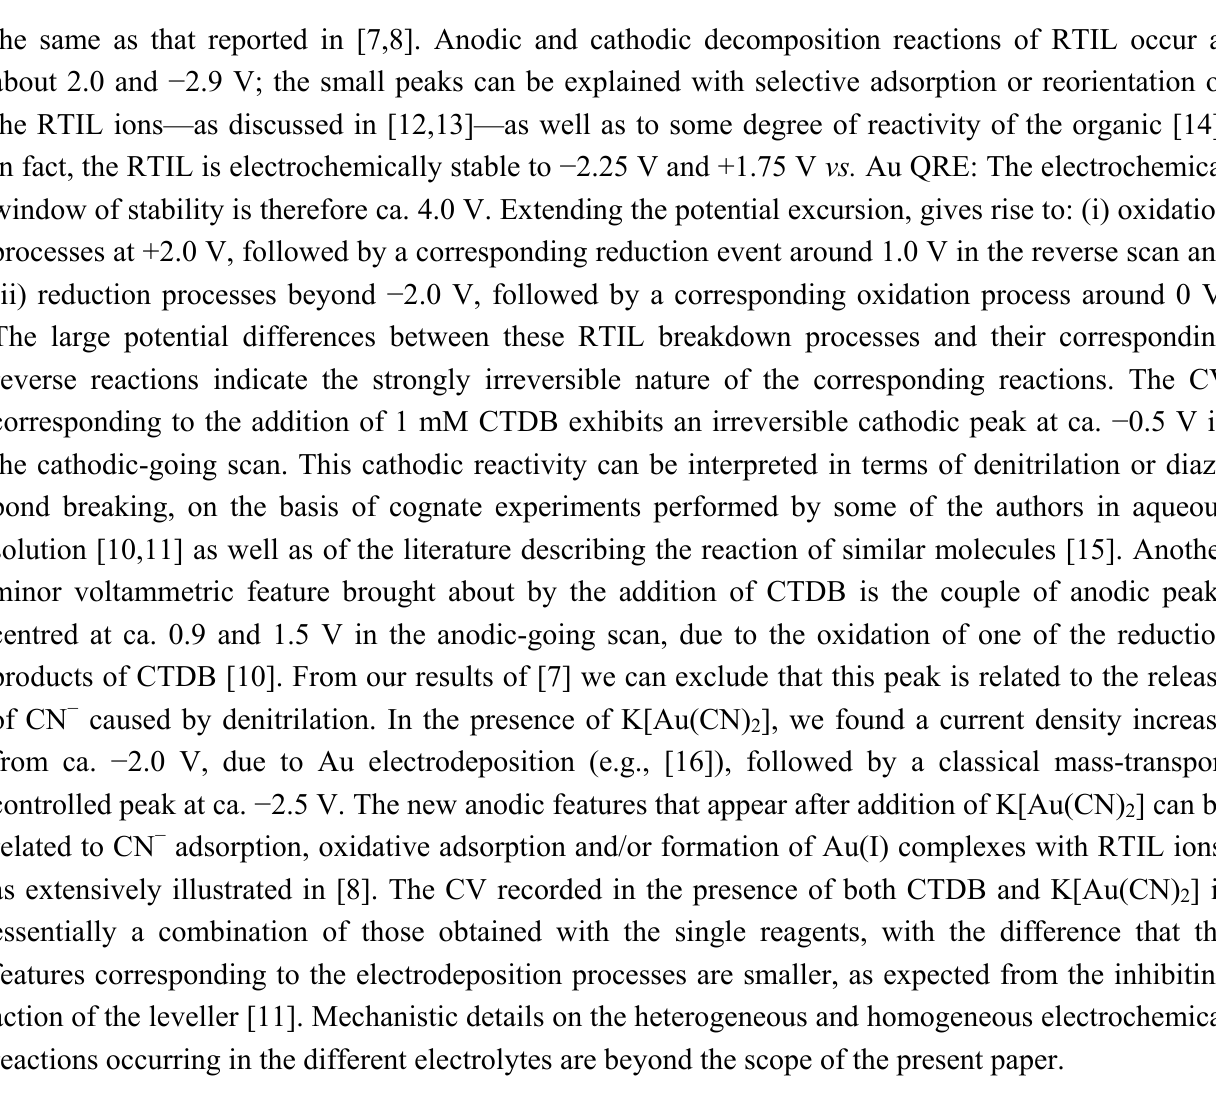
Figure 1. Cyclic voltammetries for polycrystalline Au in contact with [BMP][TFSA]- ] 25 mM. Scan rate: 0.1 V·s − 1 , scan started at based electrolytes: CTDB 1 mM, K[Au(CN) 2 0 V vs. Au QRE, initial scan direction: